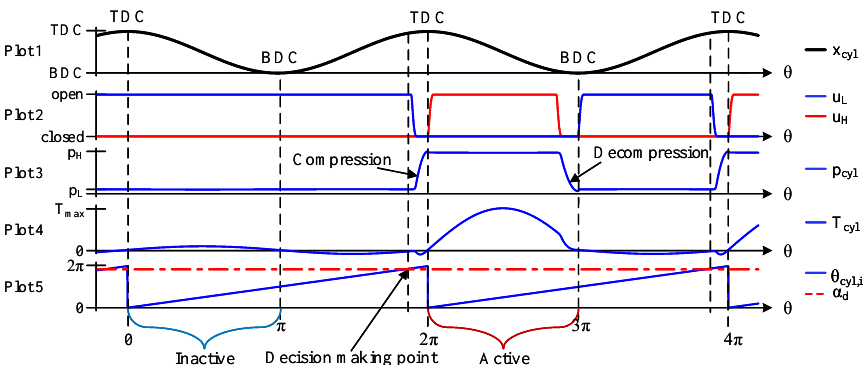
Figure 2. Valve timing schematics for the full stroke displacement